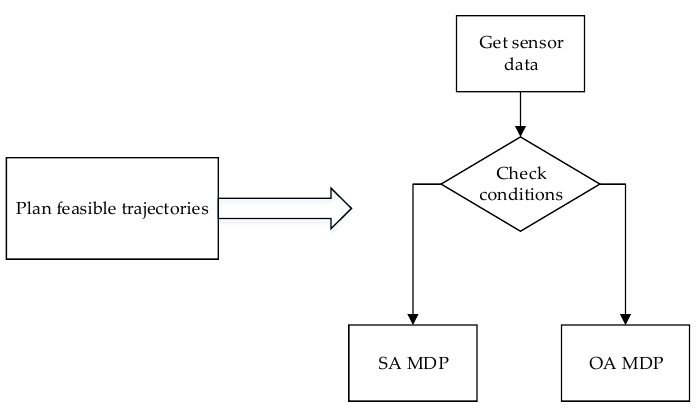
Figure 5. The flowchart of the trajectory planner.